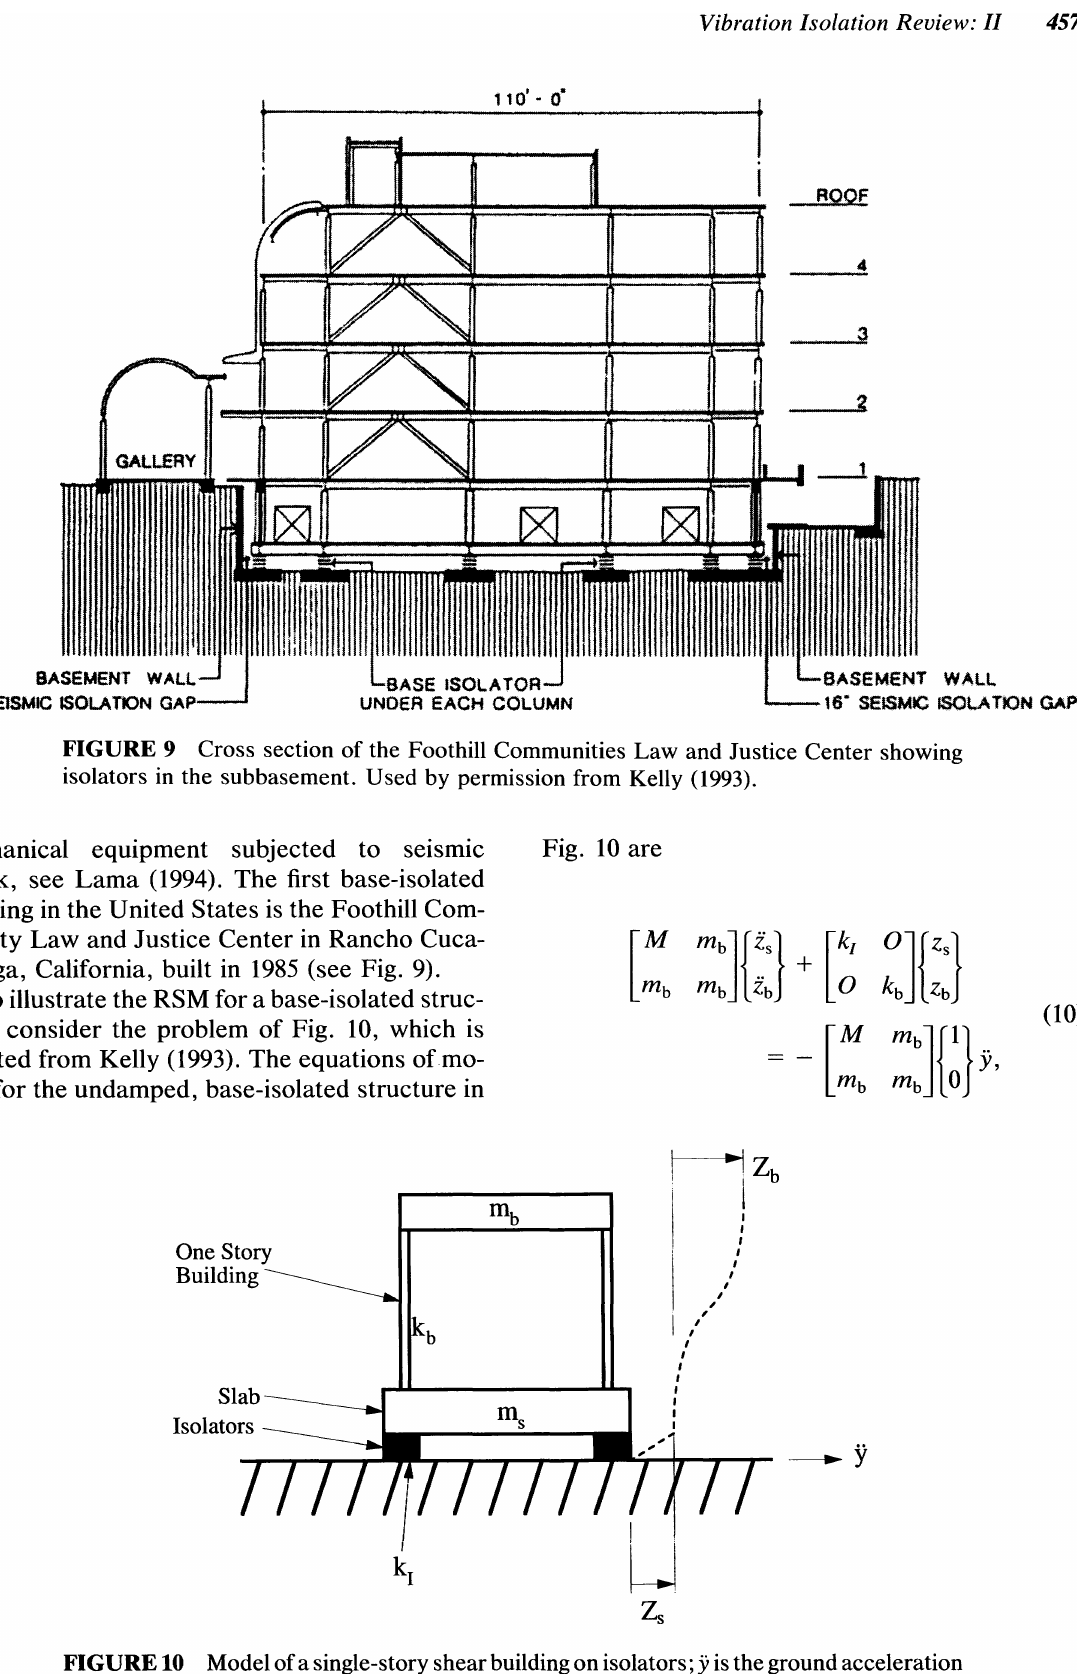
FIGURE 10 Model of a single-story shear building on isolators; y is the ground acceleration due to